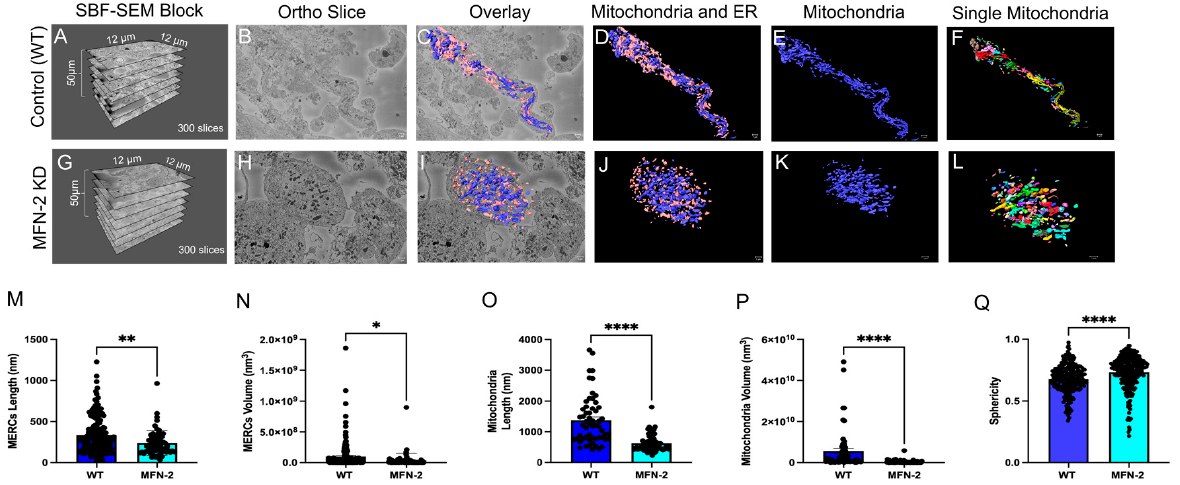
Figure 3. MFN-2 knockdown in myotubes results in smaller mitochondria and ER, with shorter MERCs. MFN-2 deficiency in myotubes leads to changes in mitochondrial (blue) and ER (pink) morphology in the mice. ( A – D ) The dimensions of SBF-SEM tissues, isolated ortho slice, 3D recon- struction overlay, and isolated 3D reconstruction in wild type myotubes. ( E ) Wild type myotubes 3D reconstructions are also shown with mitochondria individually colored and ( F ) ER individually colored. ( G – J ) The dimensions of SBF-SEM myotubes, isolated ortho slice, 3D reconstruction overlay, and isolated 3D reconstruction in MFN-2 deficient-myotubes. ( K ) 3D reconstructions of mitochon- dria in a single color and ( L ) individually colored. ( M ) When measuring MERCs, MERC length and ( N ) MERC volume both decreased. Furthermore, the ( O ) mitochondria length, ( P ) mitochon- drial average volume also decreased. ( Q ) The sphericity of mitochondria additionally decreased. Significant differences are indicated by asterisks; *, **, and **** indicate p ≤ 0.05, p ≤ 0.01, and p ≤ 0.0001,